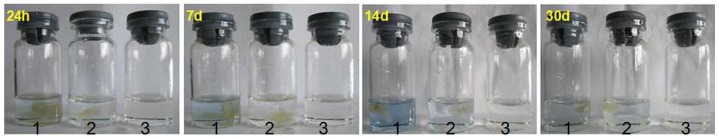
Comparison of Evans blue extravasation.1: inflamed group; 2: control group; 3: blank control. Evans blue extravasation was significantly increased at 24 h, 7d and 14d after intraprostatic injection of carrageenan.